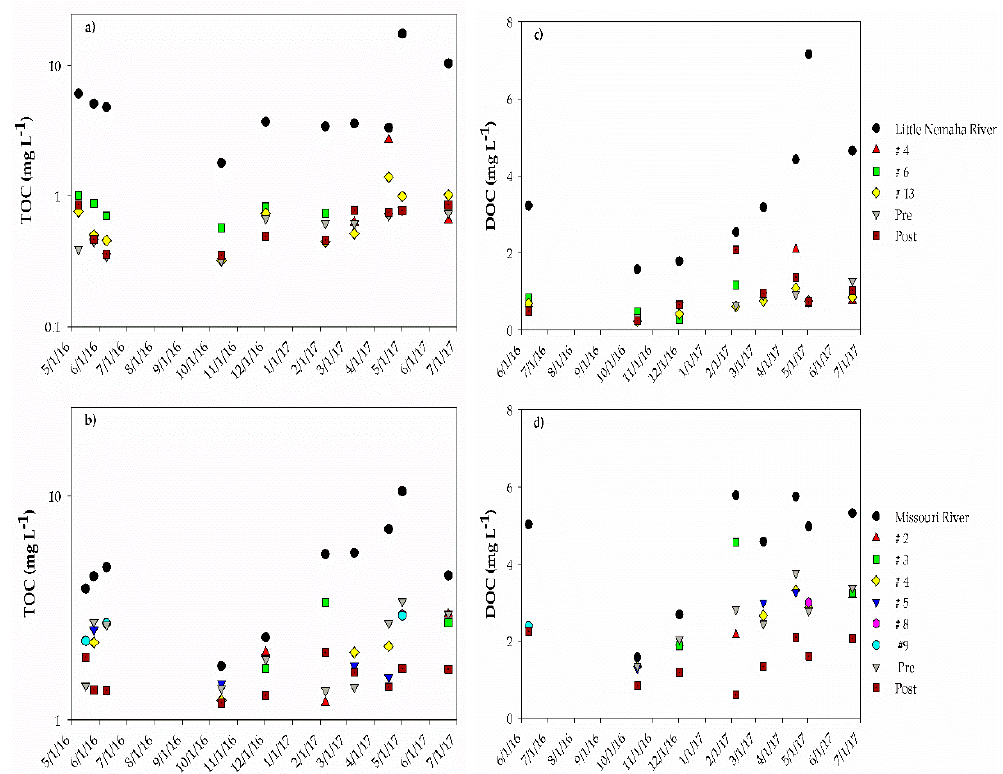
Figure 2. Total organic carbon (TOC) in ( a ) Auburn and ( b ) Nebraska City and dissolved organic carbon (DOC) in ( c ) Auburn and ( d ) Nebraska City. LNR: Little Nemaha River; MR: Missouri River; Pre: Inflow water to the water treatment plant prior to any additional treatment; Post: Water collected at the two water treatment plants after chlorination.